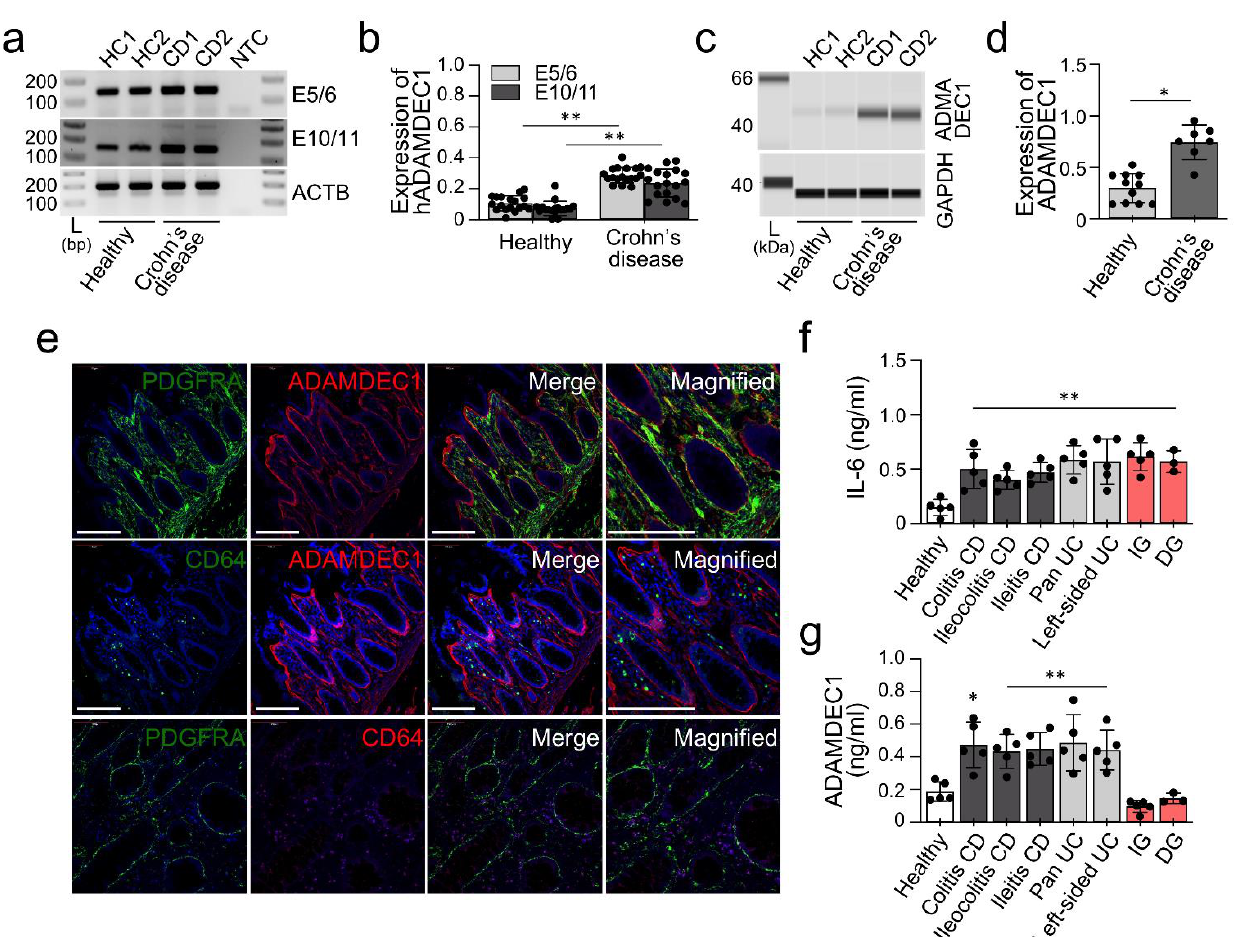
Figure 5. Induction of ADAMDEC1 in human IBD samples. ( a ) Expression of ADAMDEC1 in Crohn’s disease (CD)-affected colon and healthy controls (HC) examined with two primer sets (E5/6 and E10/11). NTC, non-template control; L, DNA marker. ACTB was used as an endogenous control. ( b ) Quantitative analysis of ADAMDEC1 in CD ( n = 15) and HC ( n = 10). ACTB was used for an endogenous control. ( c ) Changes of ADAMDEC1 proteins in Crohn’s disease-affected colon. GAPDH were used as a loading control. ( d ) Quantification of ADAMDEC1 in ( c ) normalized by GAPDH ( n = 7–10). ( e ) Localization of ADAMDEC1 protein in colonic PDGFR α + cells (PDGFRA) and surrounding epithelial layers, but not in CD64 + cells. Scale bars are 50 µ m. ( f ) Expression of IL-6 protein expression in plasma samples from CD colitis, CD ileocolitis, CD ileitis, pan ulcerative colitis (UC), left-sided UC, idiopathic gastroparesis (IG), and diabetic gastroparesis (DG) by ELISA ( n = 3–5 per groups). ( g ) Expression of ADAMDEC1 protein expression plasma samples from CD colitis, CD ileocolitis, CD ileitis, pan UC, left-sided UC, IG and DG by ELISA ( n = 3–5 per groups). * p < 0.05 and ** p < 0.01, versus